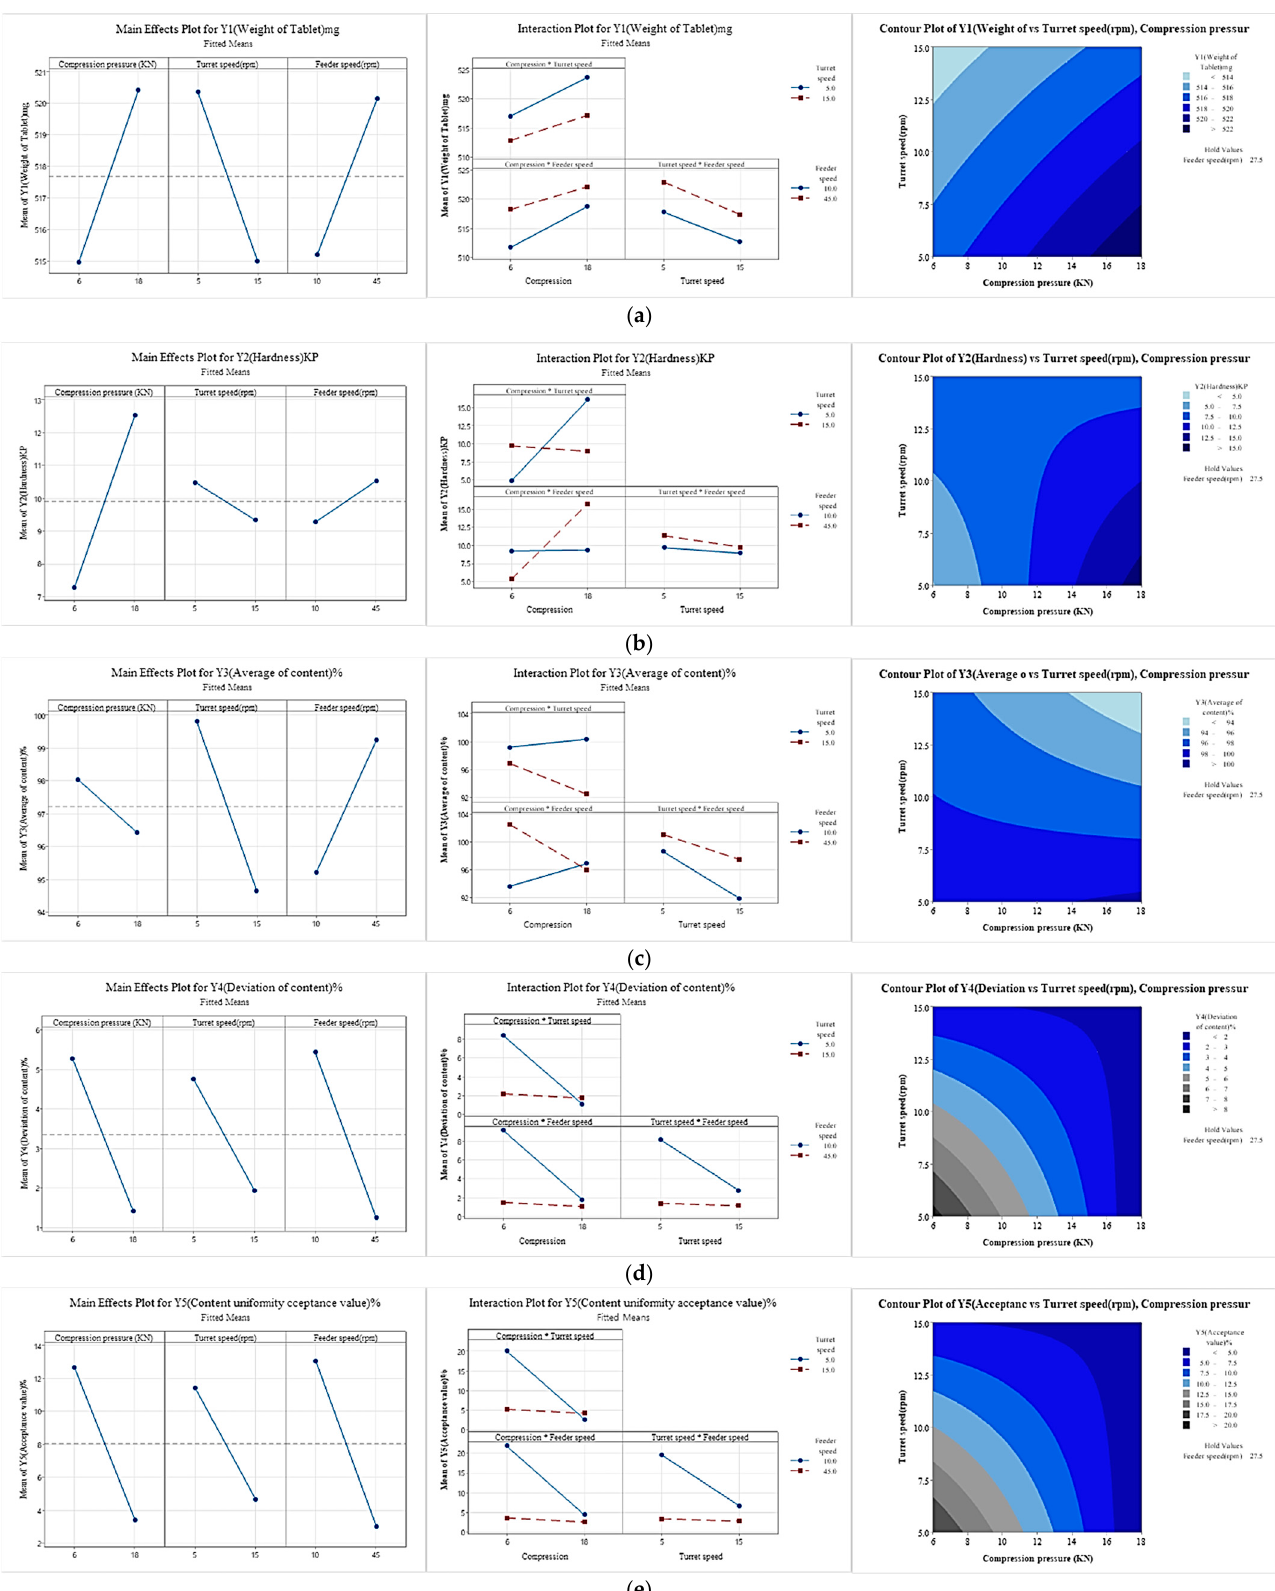
Figure 8. Effects of CPPs depicted by the main effect plots, interaction plots, and contour plots. ( a ) Y1 weight of tablet (mg), ( b ) Y2 hardness (KP), ( c ) Y3 average of content (%), ( d ) Y4 deviation of content (%), ( e ) Y5 content uniformity acceptance value (%).